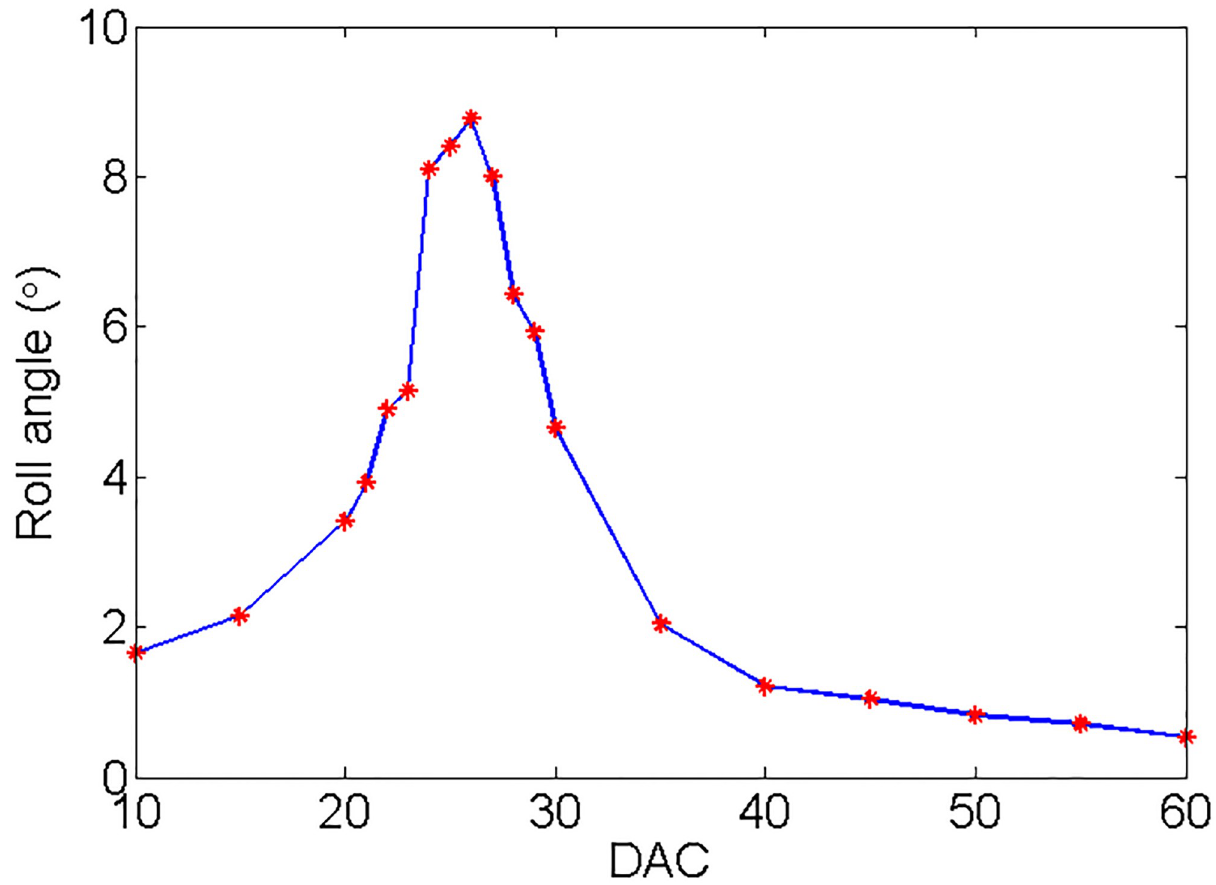
Fig 12. Results of the forced roll